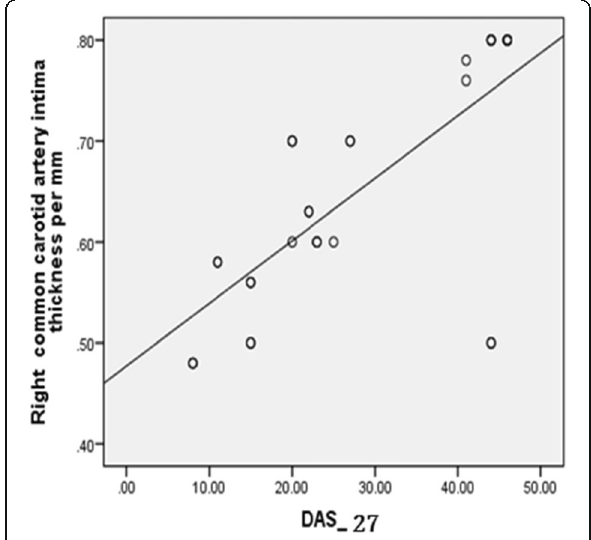
Fig. 2 Positive correlation between right common carotid artery intima-media hickness and